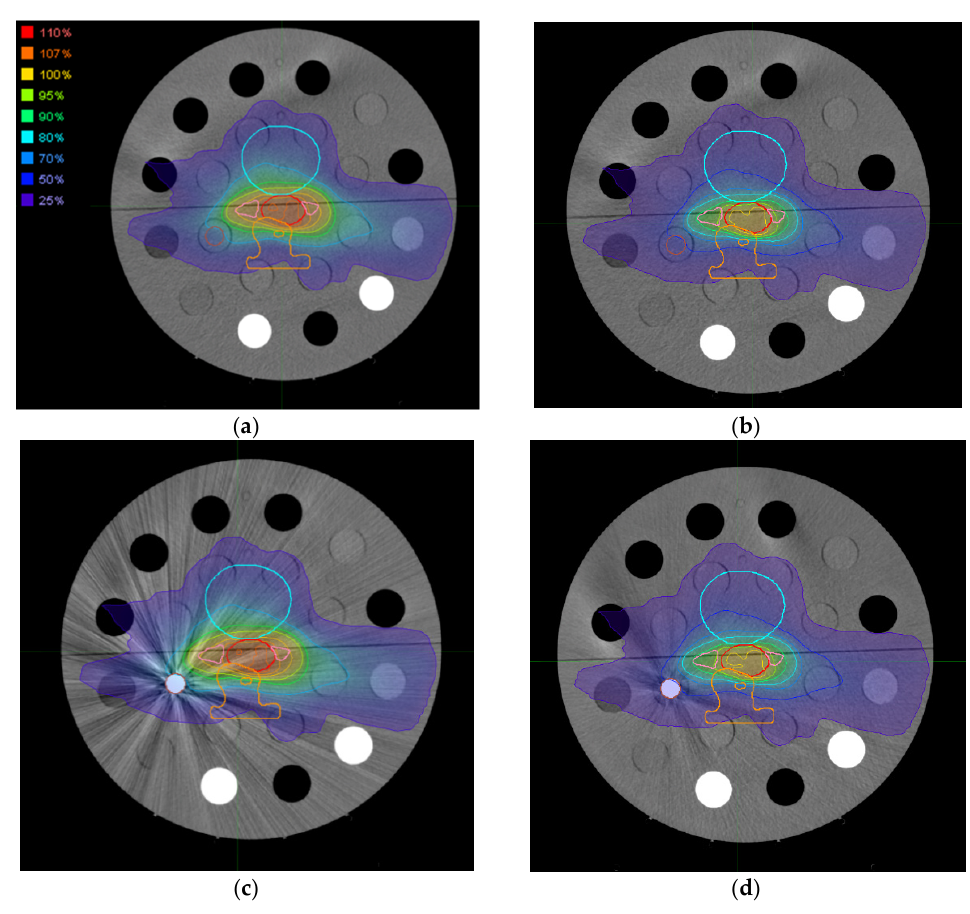
Figure 4. Isodoses, expressed as percentages of the dose to the prostate (100% = 70 Gy), on: ( a ) the ideal phantom simulating the stainless-steel insert (SRP); ( b ) the ideal phantom simulating the titanium insert (TRP); ( c ) the standard reconstruction of the CT scans of the Cheese phantom acquired at 120 kVp with the stainless-steel insert; ( d ) the standard reconstruction of the CT scans of the Cheese phantom acquired at 120 kVp with the titanium insert.